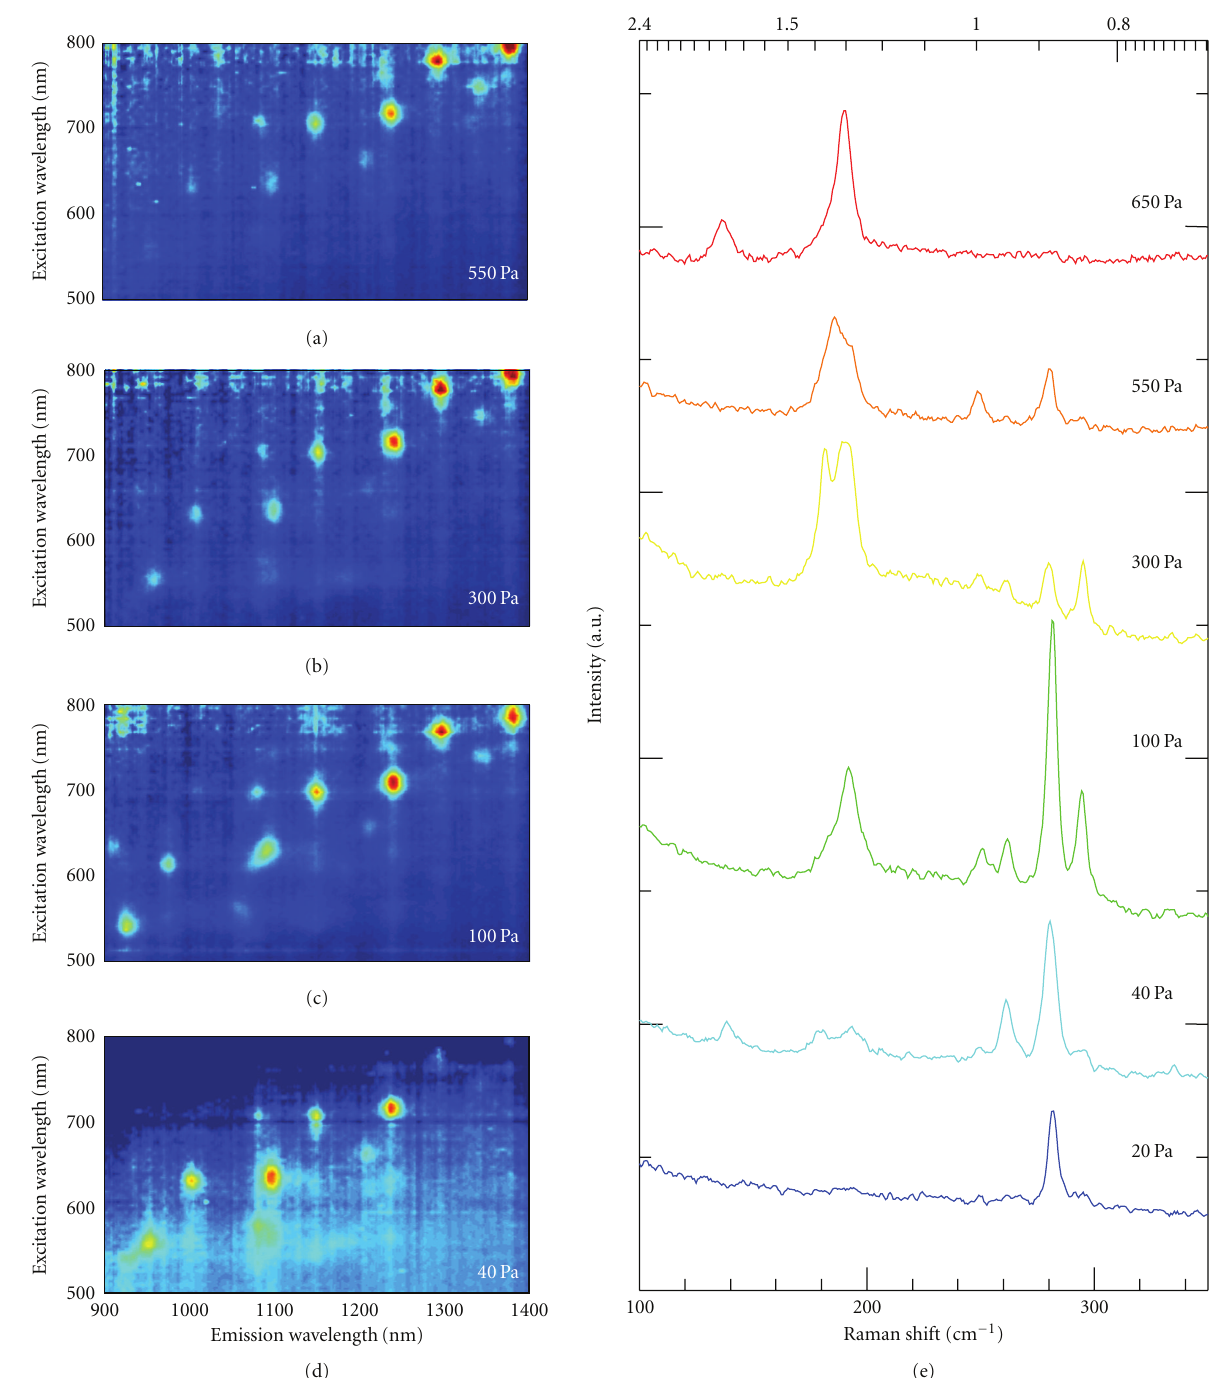
Figure 3: (a)–(d) PLE maps of as-grown freestanding SWNTs grown under di ff erent pressures ((a) 550Pa, (b) 300 Pa, (c) 100 Pa, and (d) 40Pa). (e) Dependence of the RBM in Raman scattering spectra on growth pressure for as-grown freestanding SWNTs. SWNT sample also confirmed the growth of the (6,5) SWNTs (Figure 4(e)). This is the first result showing narrow chirality distributions for SWNTs grown from a nonmagnetic